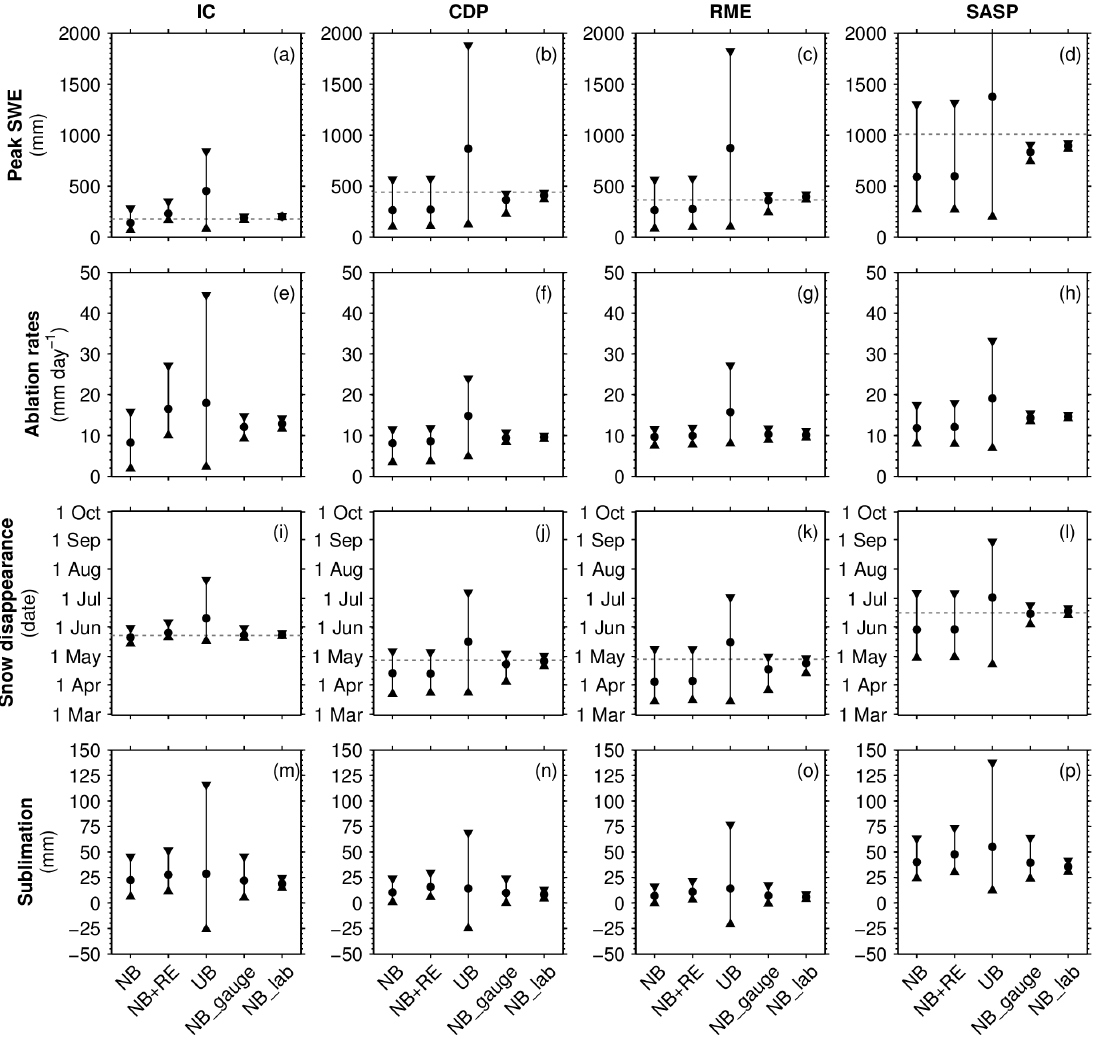
Figure 4. Distributions of model outputs (rows) at the four study sites (columns) arranged by scenario. For each scenario, the circle is the mean and the whiskers show the range encompassing 95% of the simulations (see Table 4 for number of simulations for each site and scenario). The dashed lines in (a) – (d) and (i) – (l) are the observed values. Axes are matched between sites for a given model output; note that the range in scenario UB in (d) is truncated by the axes’ limits (upper value =